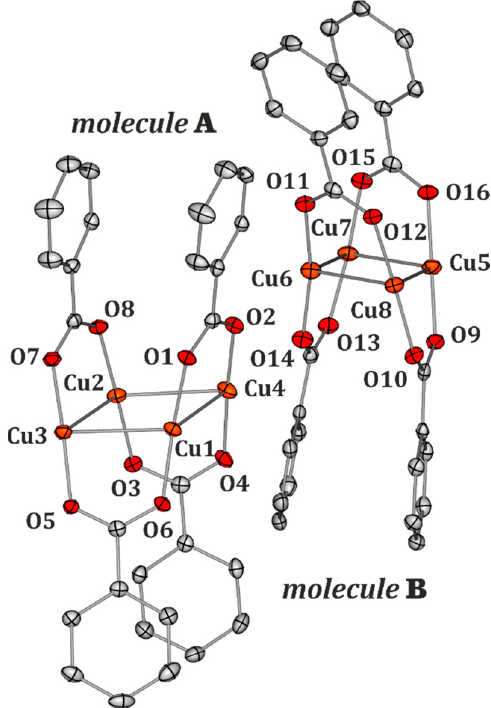
Figure 1. Molecular structures of two symmetry-independent molecules of Cu 4 in the crystal lattice (90 K data set used). Atomic thermal motion is represented as ellipsoids (50% probability level). Hydrogen atoms have been removed for clarity. Table 1. Selected geometrical parameters describing the molecular cores of both independent molecules present in the Cu 4 crystal structure at different temperatures.